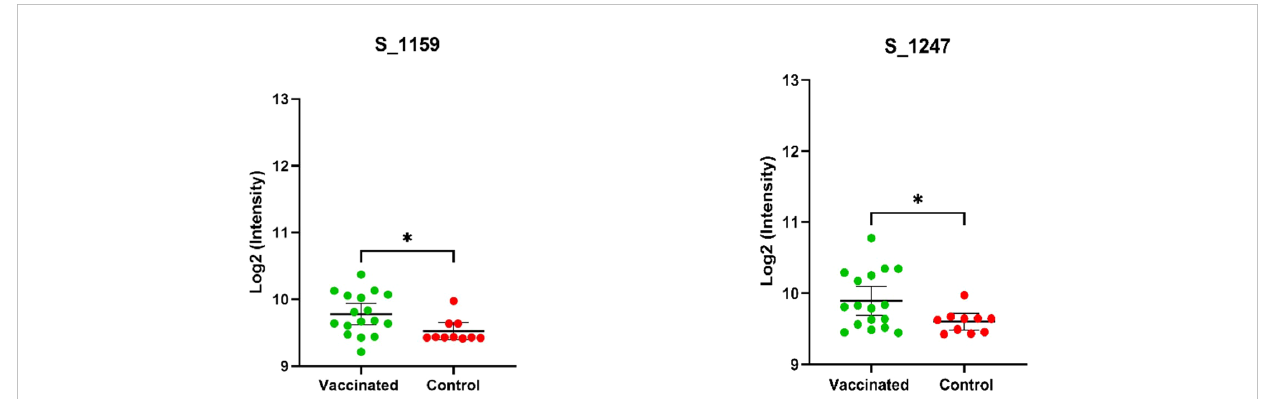
FIGURE 2 Depicted above are mean log2 normalized fl uorescent intensities of the vaccinated and control groups that were found to be signi fi cantly different (p- value <.05) based on the results of an unpaired t-test. The ID and results of the t-test (* <.05) are displayed above the plots. The vaccinated group was not found to have a fold change greater than 1.5 and, therefore, these peptides were not recognized as epitopes of high interest based on our